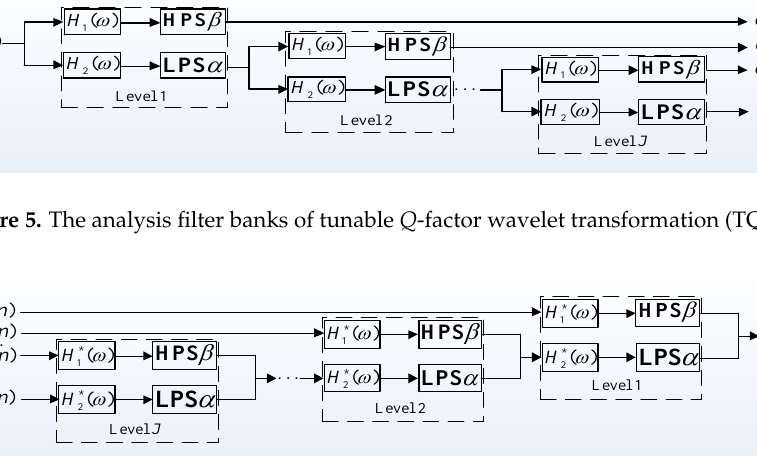
Figure 6. The synthesis filter banks of TQWT.